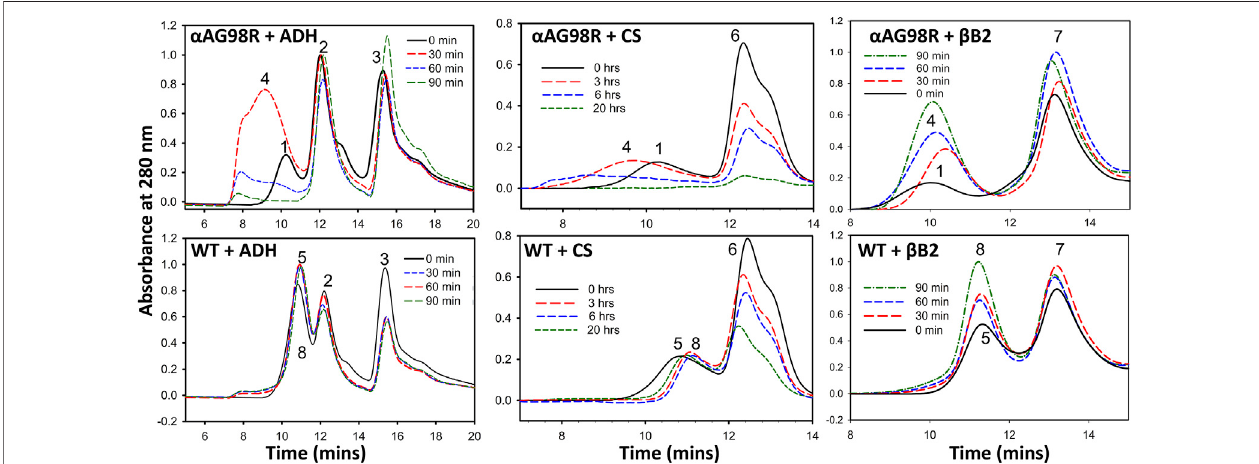
FIGURE 2 | Gel fi ltration elution pro fi les of incubation mixtures of substrate proteins with α AG98R or α A-WT at different time intervals. The peaks are identi fi ed as follows 1 — α AG98R or complex at 0 min; 2 — ADH tetramer; 3 — ADH monomer; 4 — α AG98R-substrate complexes; 5 — α A-WT or complex at 0 min; 6 — CS; 7 — β B 2 - crystallin; 8 — α A-WT-substrate complexes. Only the area under peaks 1, 4, 5, and 8 are analyzed using ASTRA software, and the results are summarized in Table 1